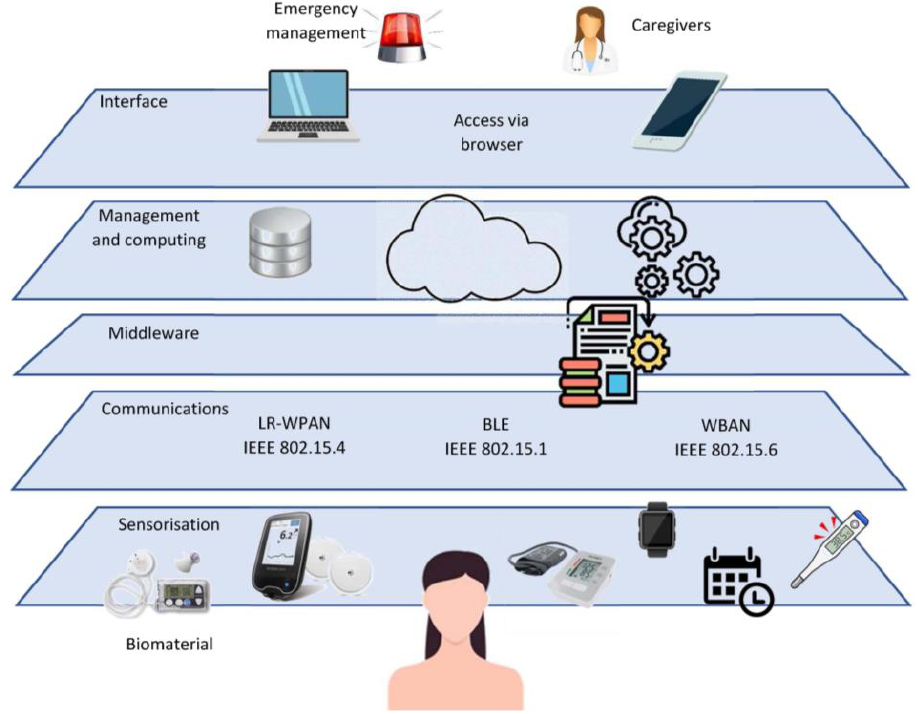
Figure 4. IoMT structure for DM1 management.